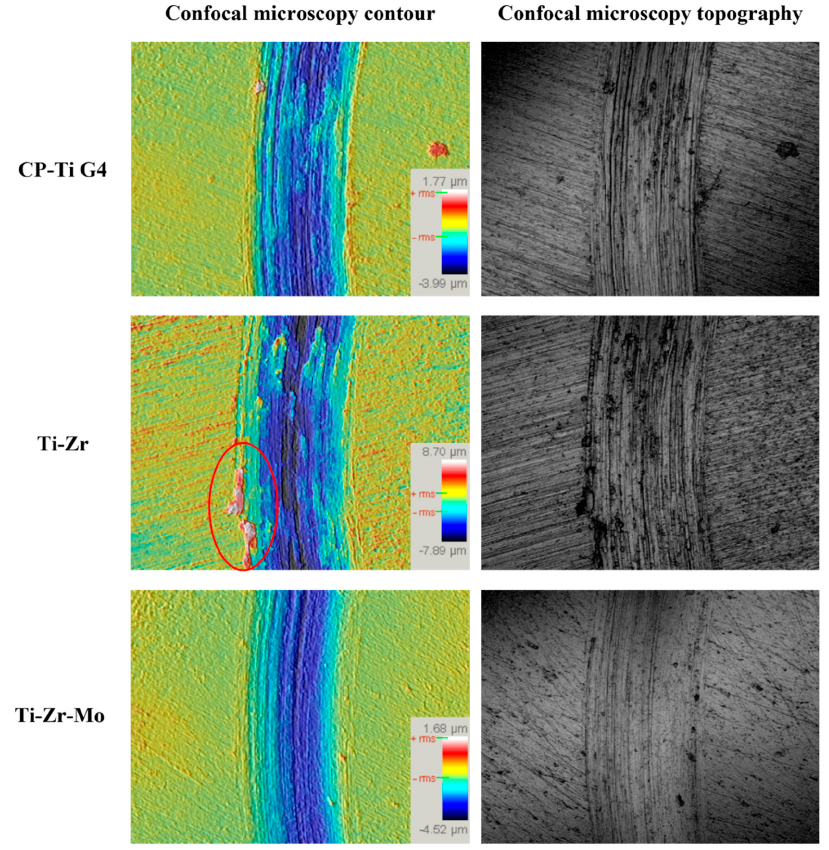
Materials 2023 , 16 , x FOR PEER REVIEW Figure 9. Profiles obtained by confocal microscopy 100× in the central region of the wear tracks. Figure 9. Profiles obtained by confocal microscopy 100 × in the central region of the wear tracks.